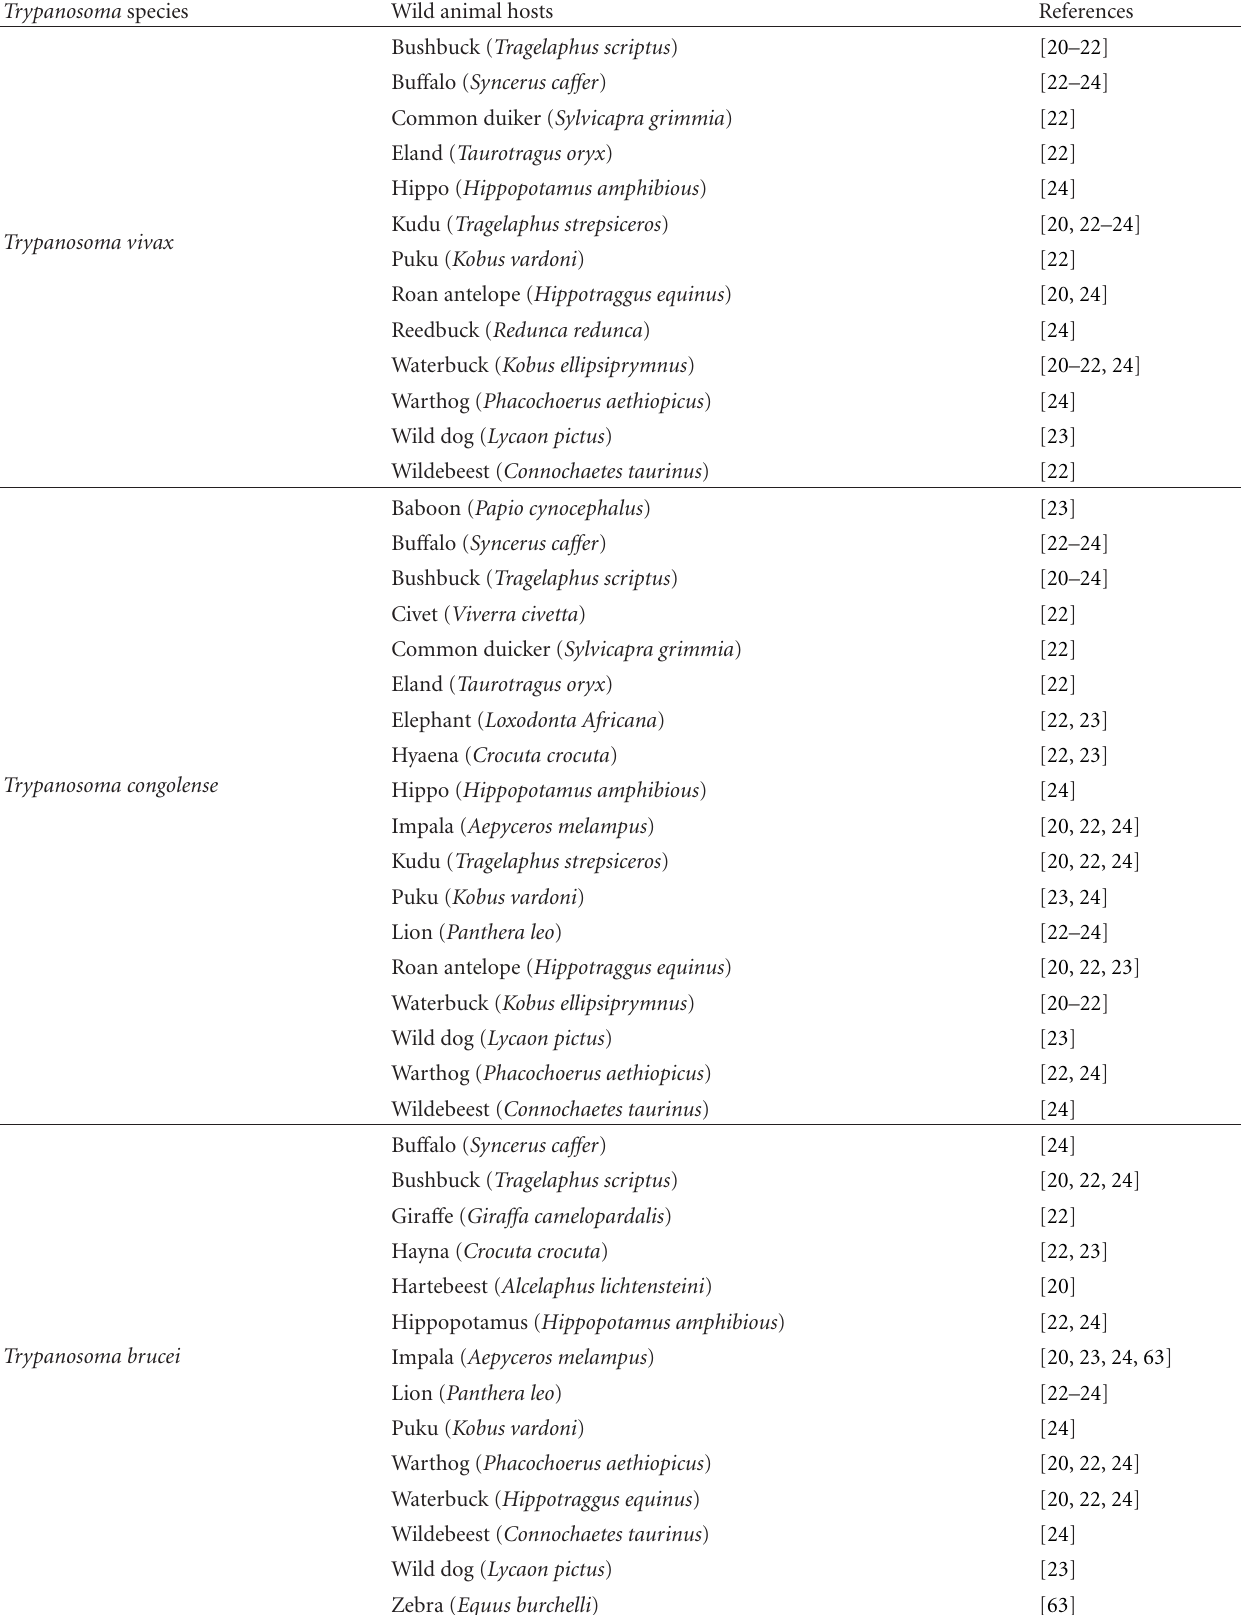
Table 2: Trypanosoma species detected from wildlife in the Luangwa and Zambezi